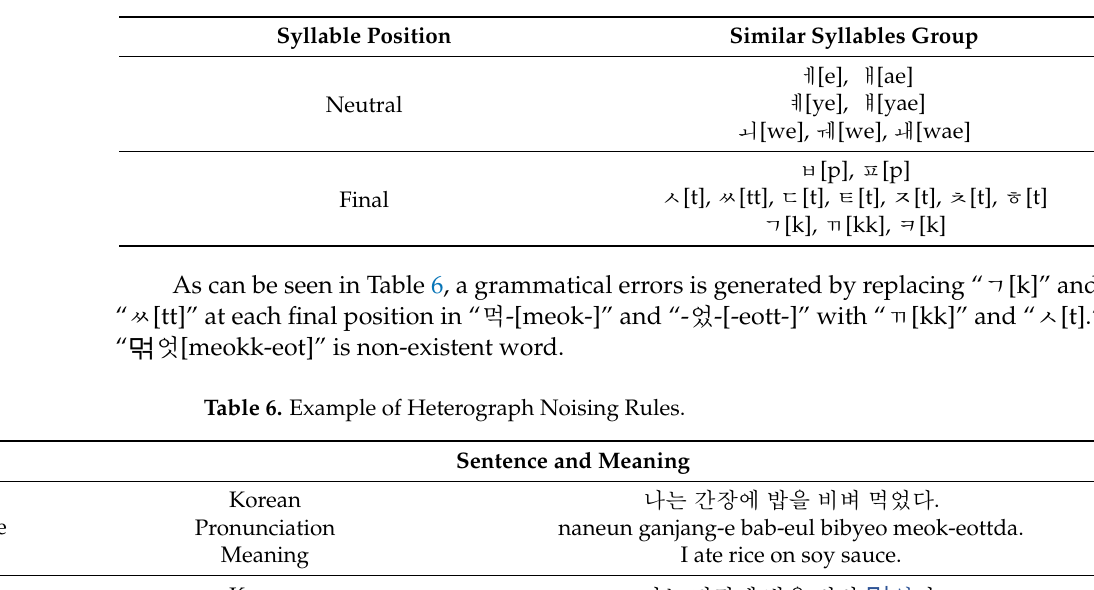
Table 5. Similar Syllables Group Table.